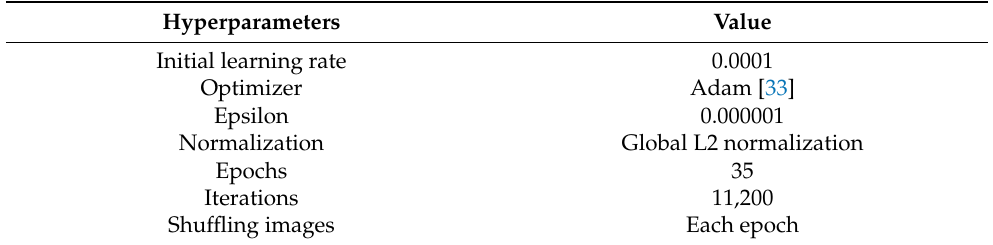
Table 2. Training hyperparameters used to train the proposed DFS-Net and